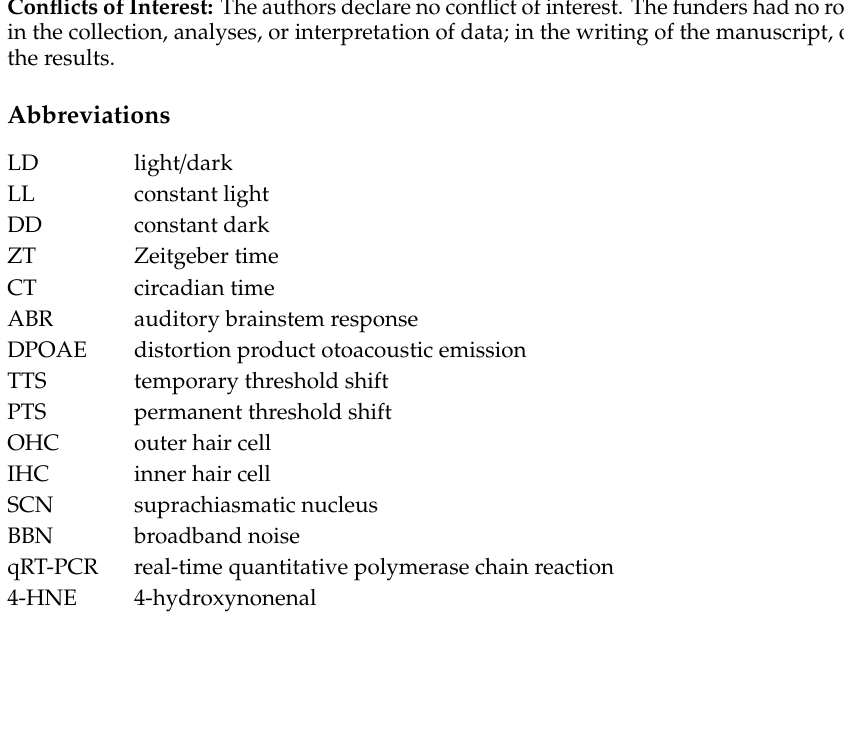
Figure S1. Representative images of PER2 immunostaining in the cochlea and organ of Corti under normal LD